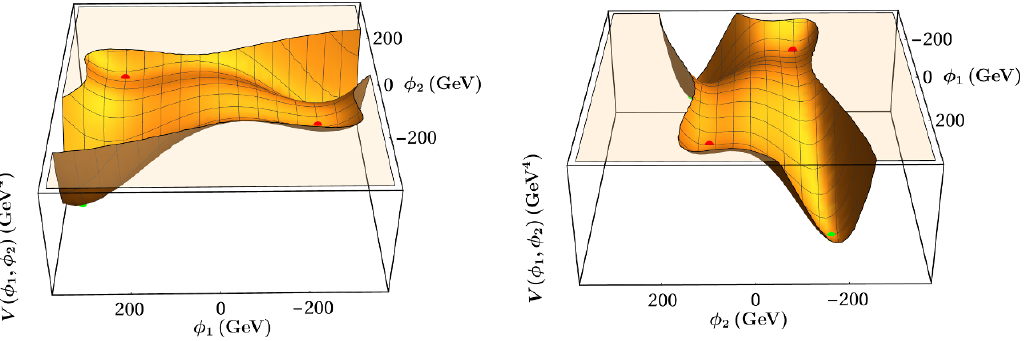
Figure 3 . Left panel: plot of the potential V ( (cid:30) 1 ; (cid:30) 2 ) of eq. (2.2) for the parameters given of eq. (5.1). Right panel: the same potential rotated anticlockwise by 90 degrees. The left panel better shows the decay path from N to N 0 ; the right panel from N to N 0 . The path connecting N while N 0 is longer than the path connecting N with N 0 . False minima marked in red, true ones in